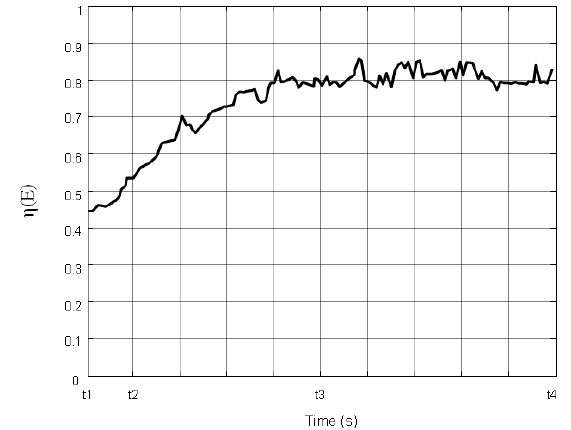
Figure 15. The varying of the coverage efficiency in the comparison